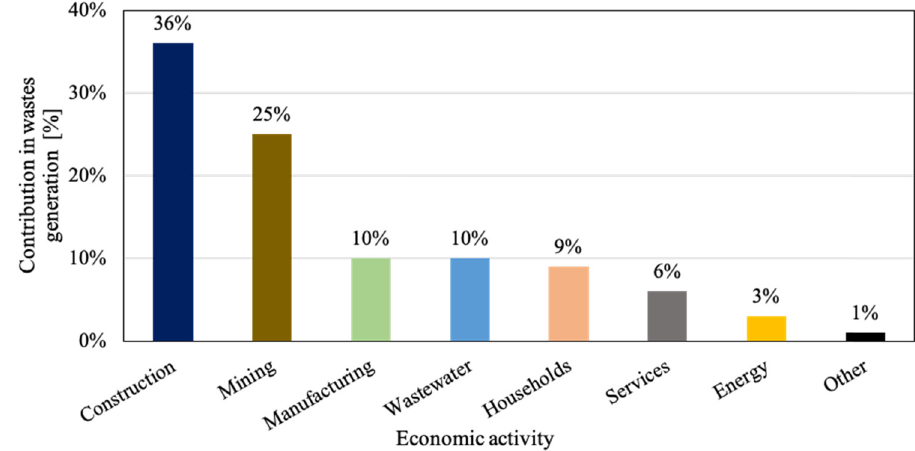
Figure 1: Waste generation by economic activities and households in Europe in 2018 [ 23 ]